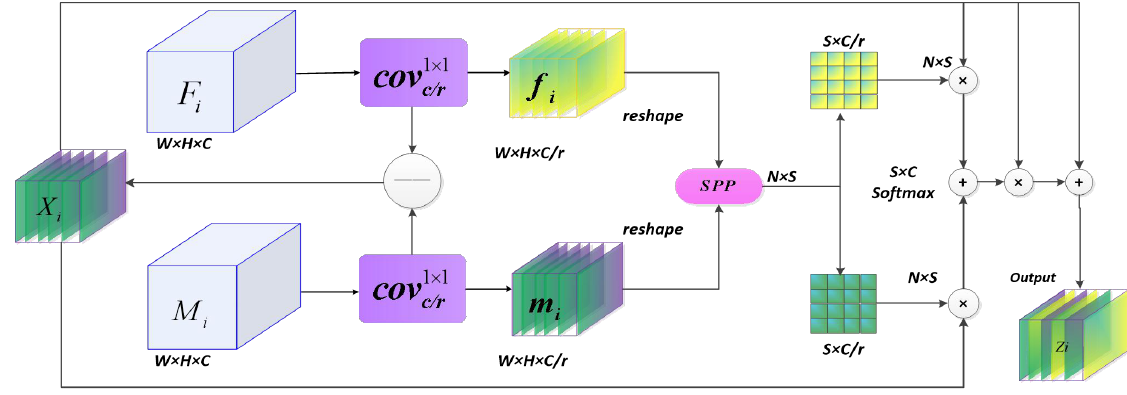
Figure 2 . Multiscale change-aware